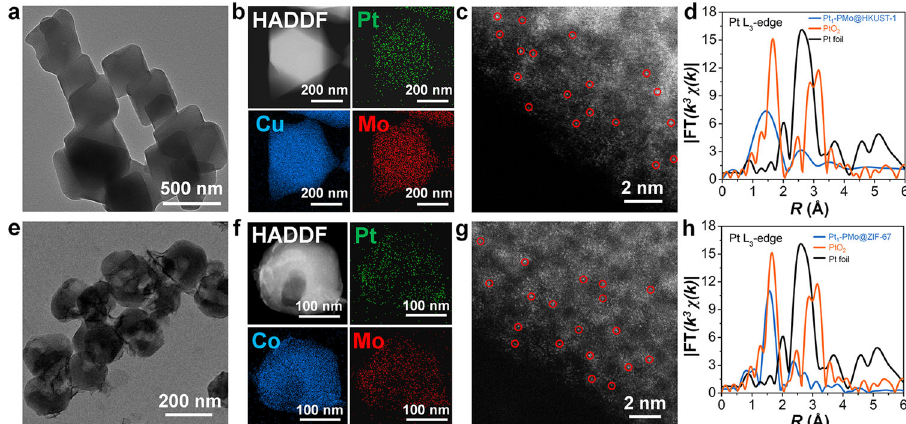
Fig. 5 Characterizations of Pt 1 -PMo@HKUST-1 and Pt 1 -PMo@ZIF-67. a TEM images of Pt 1 -PMo@HKUST-1. b HAADF-STEM images and corresponding element maps showing distributions of Pt (green), Cu (blue), and Mo (red) in Pt 1 -PMo@HKUST-1, respectively. c Aberration-corrected HAADF-STEM images of Pt 1 -PMo@HKUST-1. d Fourier transforms of k 3 -weighted Pt L 3 -edge EXAFS experimental data for Pt 1 -PMo@HKUST-1. e TEM images of Pt 1 - PMo@ZIF-67. f HAADF-STEM images and corresponding element maps showing distributions of Pt (green), Co (blue), and Mo (red) in Pt 1 -PMo@ZIF-67, respectively. g Aberration-corrected HAADF-STEM images of Pt 1 -PMo@ZIF-67. h Fourier transforms of k 3 -weighted Pt L 3 -edge EXAFS experimental